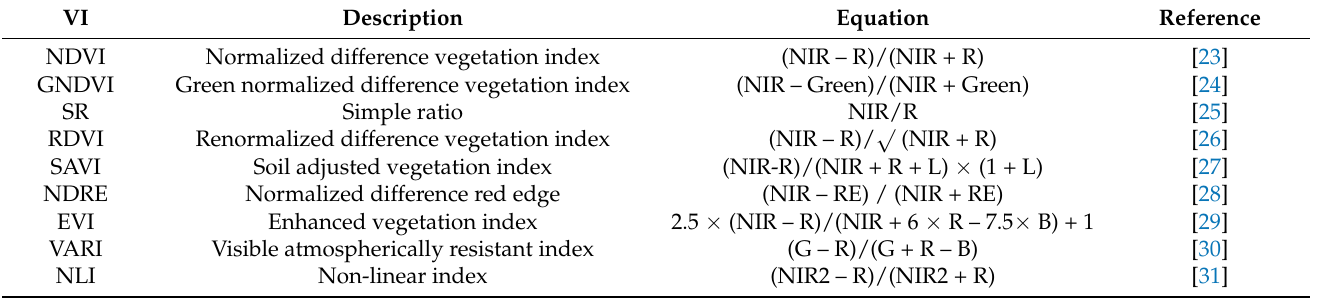
Table 2. Vegetation index (VI), description, equation, and reference used to analyze nematode infection.